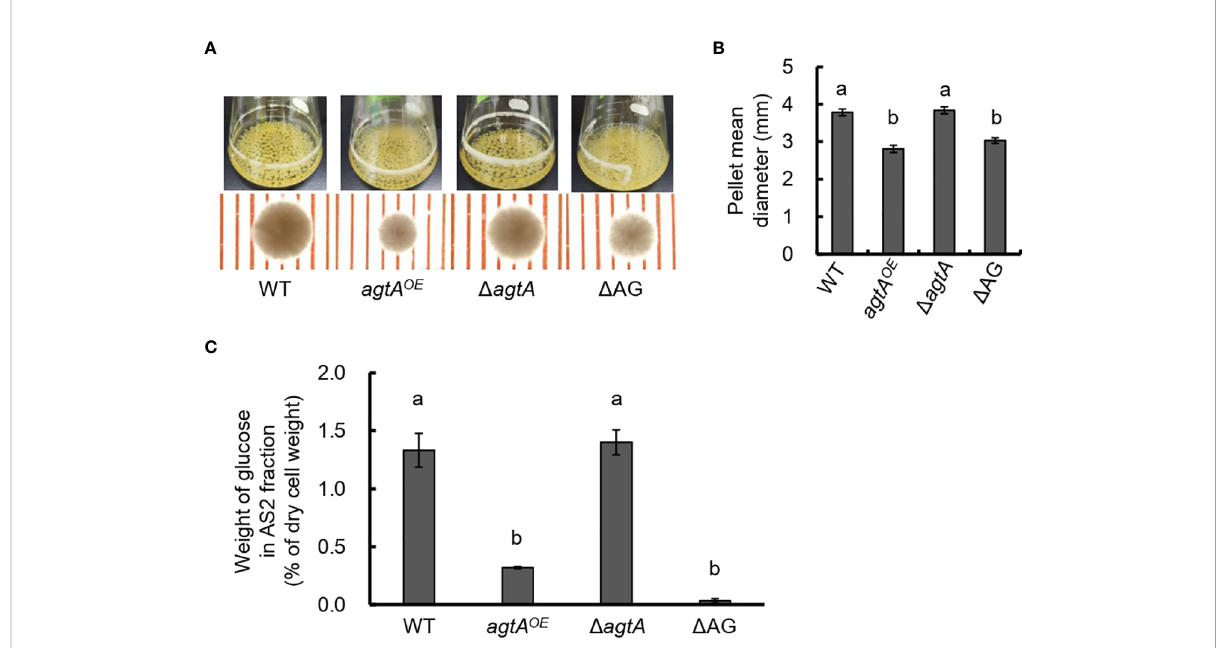
FIGURE 2 Analysis of the agtA OE strain of A. oryzae . (A) Growth characteristics of A . oryzae wild-type (WT), agtA OE , D agtA , and D AG strains in submerged culture. Conidia (1 × 10 5 /mL) of each strain were inoculated into 50 mL of YPD medium and rotated at 120 rpm at 30°C for 24 h. Upper images, cultures in Erlenmeyer fl asks; lower images, representative hyphal pellets under a stereomicroscope (scale = 1 mm). (B) The mean diameter of hyphal pellets. Error bars represent the standard error of the mean calculated from three replicates. Different letters above bars indicate signi fi cant difference by Tukey ’ s test ( P < 0.01). (C) Amount of glucose in the alkali-soluble water-insoluble (AS2) fraction. Error bars represent the standard error of the mean calculated from three replicates. Different letters above bars indicate signi fi cant difference by Tukey ’ s test ( P <